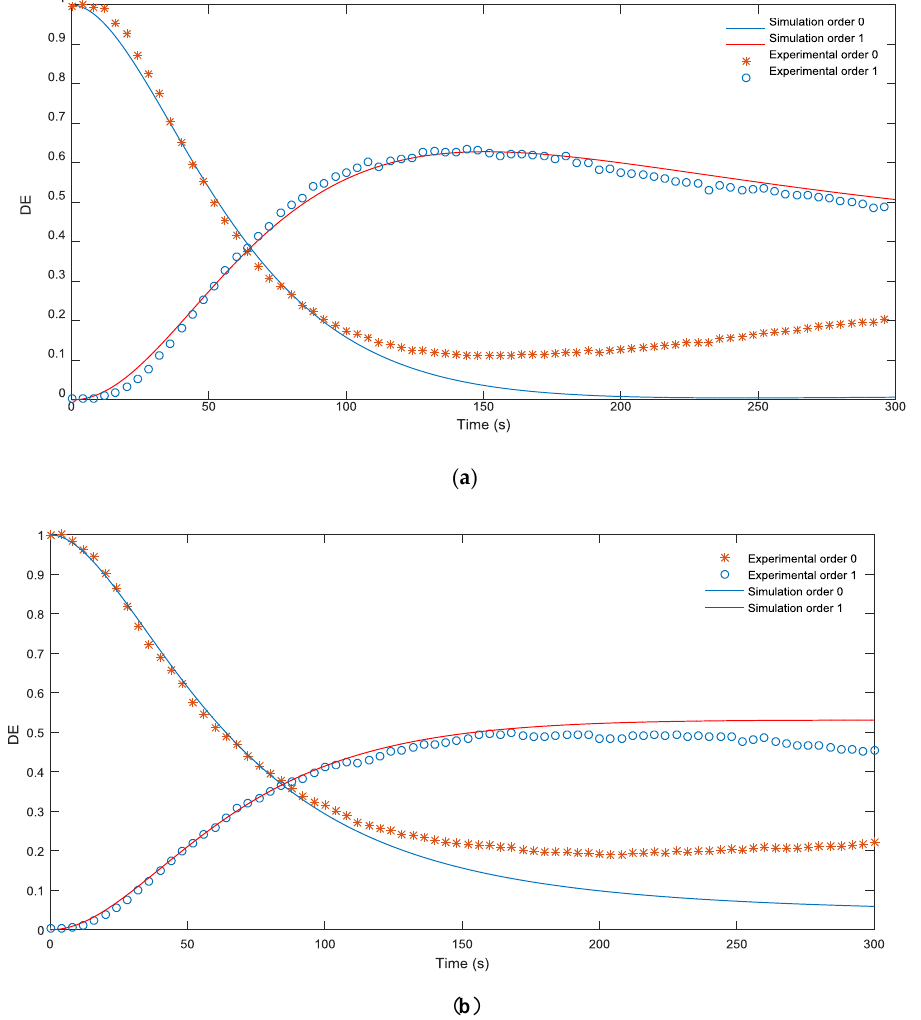
Figure 5. ( a ) Comparison of the simulated and experimental DE of a 672 um blazed grating recorded in PVA/NaAO material over a period of 300 s; ( b ) Comparison of the simulated and experimental DE a 336 μm blazed grating recorded in PVA/NaAO material over a period of 300